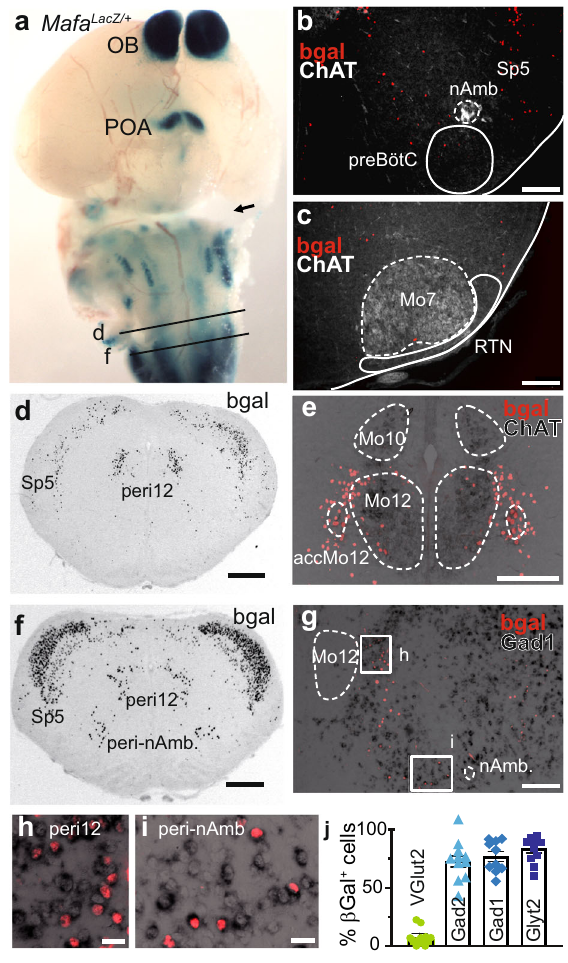
Fig. 2 Mafa + neurons of the reticular formation in the caudal medulla are inhibitory. a Whole mount (ventral view) of a M afa LacZ/ + brain at E15 showing Mafa expression (Xgal staining, dark blue) restricted to the olfactory bulb (OB), to the pre-optic area of the hypothalamus (POA) to the brainstem (pons and medulla) and to the spinal cord. b Hemi-transverse section (medial left, dorsal top) of a M afa LacZ/ + pup at P0 showing that the preBötC area, below ChAT + neurons (white) of the nucleus ambiguous (nAmb), is devoid of gal + cells (red). c Same as b showing the absence of bgal + cells (red) in the RTN, below ChAT + neurons (white) of the facial motor nucleus (Mo7). d Transverse section of a M afa LacZ/ + pup at P0 (at the d axial position indicated in a) showing Mafa + cells immunostained for bgal (black) in the caudal medulla in the spinal part of the trigeminal nucleus (sp5), in the peri12 reticular formation laterally to the hypoglossal motor nucleus (Mo12), in motoneurons of the accessory hypoglossal motor nucleus (acc- Mo12). e Close-up view of Mafa + peri12 neurons (red) counterstained for ChAT + (black) motoneurons at the same axial level as d . Transverse section (at the f axial position indicated in a ) showing Mafa + cells in the Sp5 and medial to the nucleus ambiguus in the peri-nAmb area. g Close up view of a hemi-transverse section (medial left, dorsal top) showing Mafa + cells (red labeling) combined to Gad1 in situ hybridization (black) at the same axial level as ( f ) showing Gad1 + /Mafa + cells in the peri12 and peri-nAmb. Close-up view from the ( h ) inset in ( g ). Close-up view from the i inset in ( g ). j Quanti fi cation of neurochemical types of Mafa + neurons of the caudal medulla reticular formation by in situ hybridization for VGlut2 (13 section counts), Glyt2 (11 section counts), Gad1 (10 section counts) and Gad2 (12 section counts). Note that Mafa + neurons of the caudal reticular formation (peri12 and peri-nAmb regions) are predominantly inhibitory. Plots represent mean±sem. Scale bars ( μ m): 100 ( b – g ), 20 ( h , i